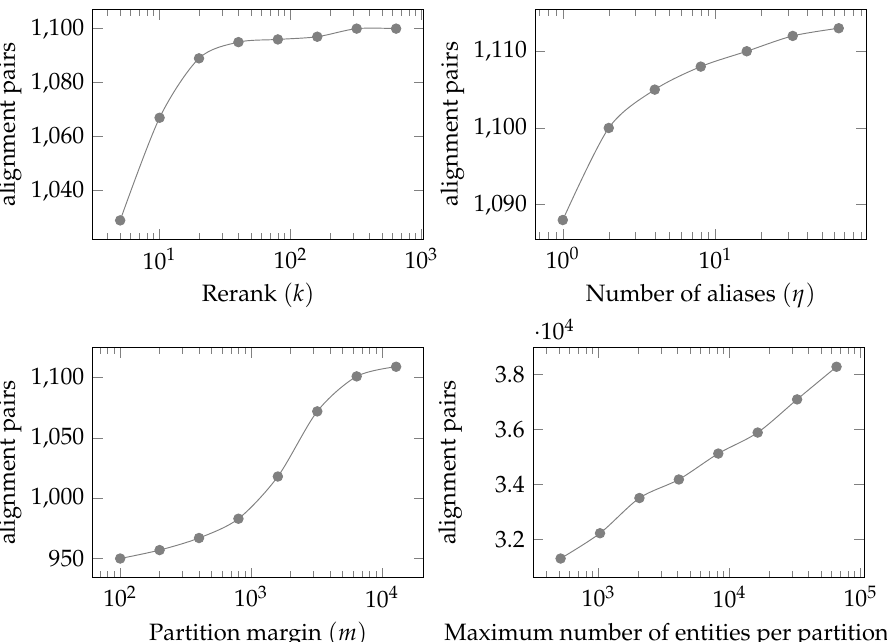
Figure 8. Evaluation of the impact of rerank k ( top-left ), number of aliases η ( top-right ), the parti- tion margin m ( bottom-left ) and maximum number of entities per partition N W ( bottom-right ) on alignments